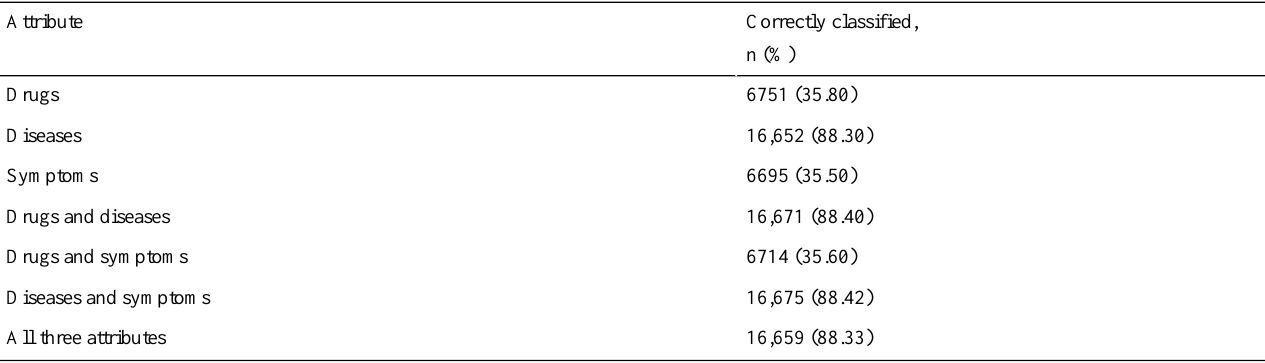
Table 2. Percentage of correctly classified self-identified users (SIUs) given users’ queries for drugs, diseases, symptoms, and their combinations (n=18,859).